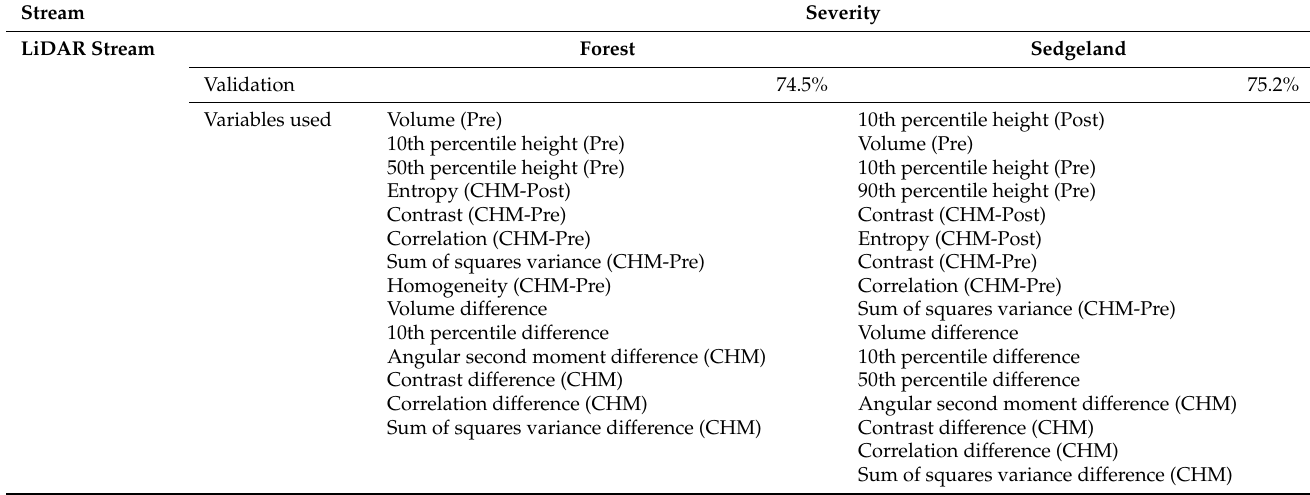
Table A3. Summary of accuracy derived from the validation dataset and predictor variables used in LiDAR-only stream.